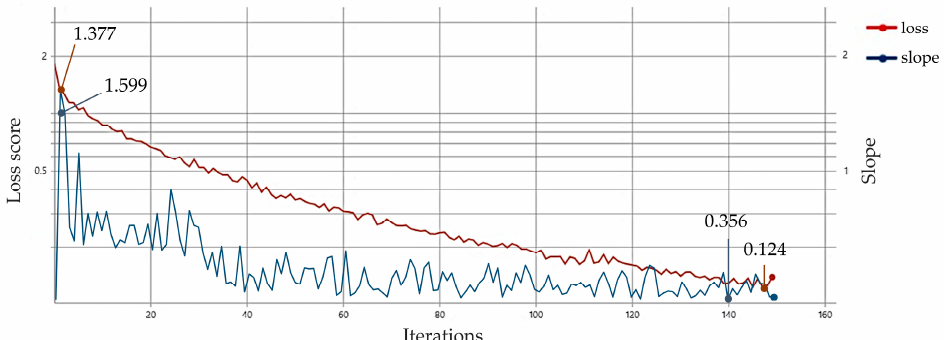
Figure 5. Loss graph for iterations in object detection. The loss score corresponds to the error rate of the neural network. If the loss score decreases as the iteration increases in the training process of the deep learning model, it means that the object detection performance of the model is improved. The slope of the loss score for iteration on the x-axis is defined as a line smooth value.